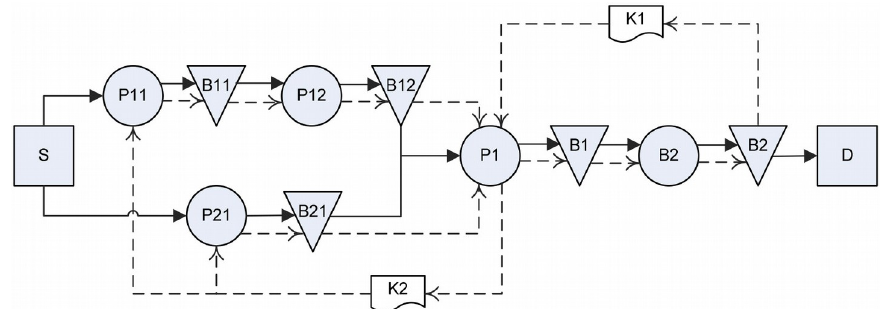
Figure 8. Conceptual mechanism of Hybrid4 (A6) system